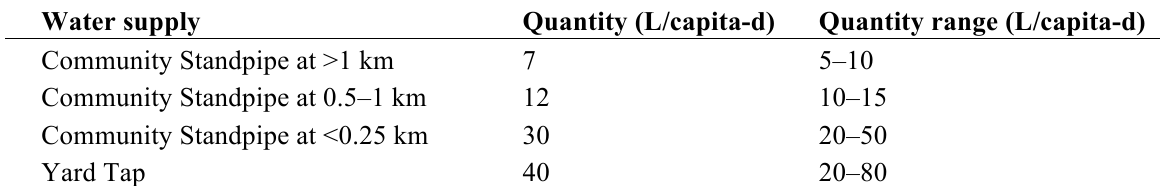
Table 4. Data for typical rural community in a resource-limited country